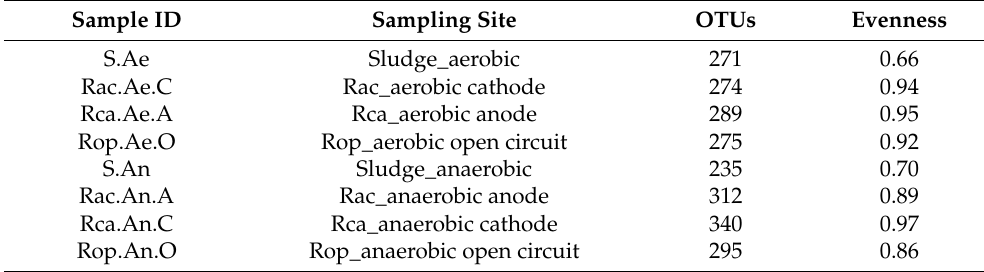
Table 3. Species diversity and abundance index of eight samples.